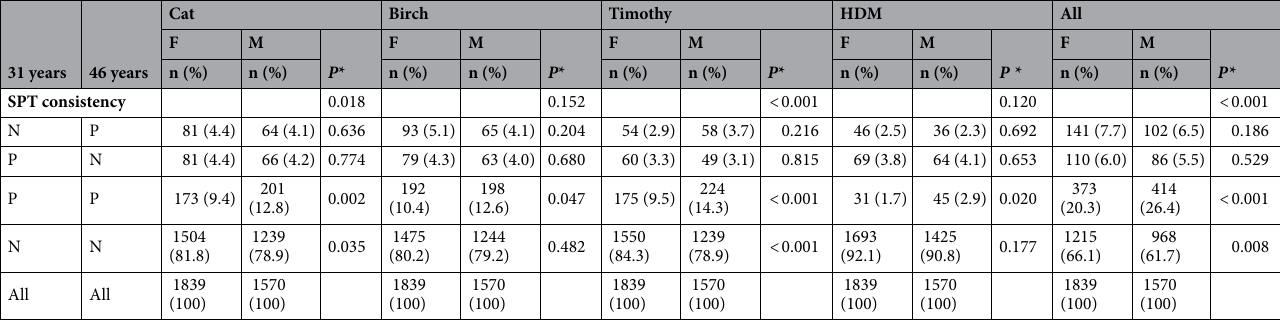
Table 3. Consistency of SPT findings between ages 31 and 46 by sex. HDM house dust mite, SPT skin prick test, F female, M male, y years, N negative, P positive, Ref Reference. * P value for difference between sexes.